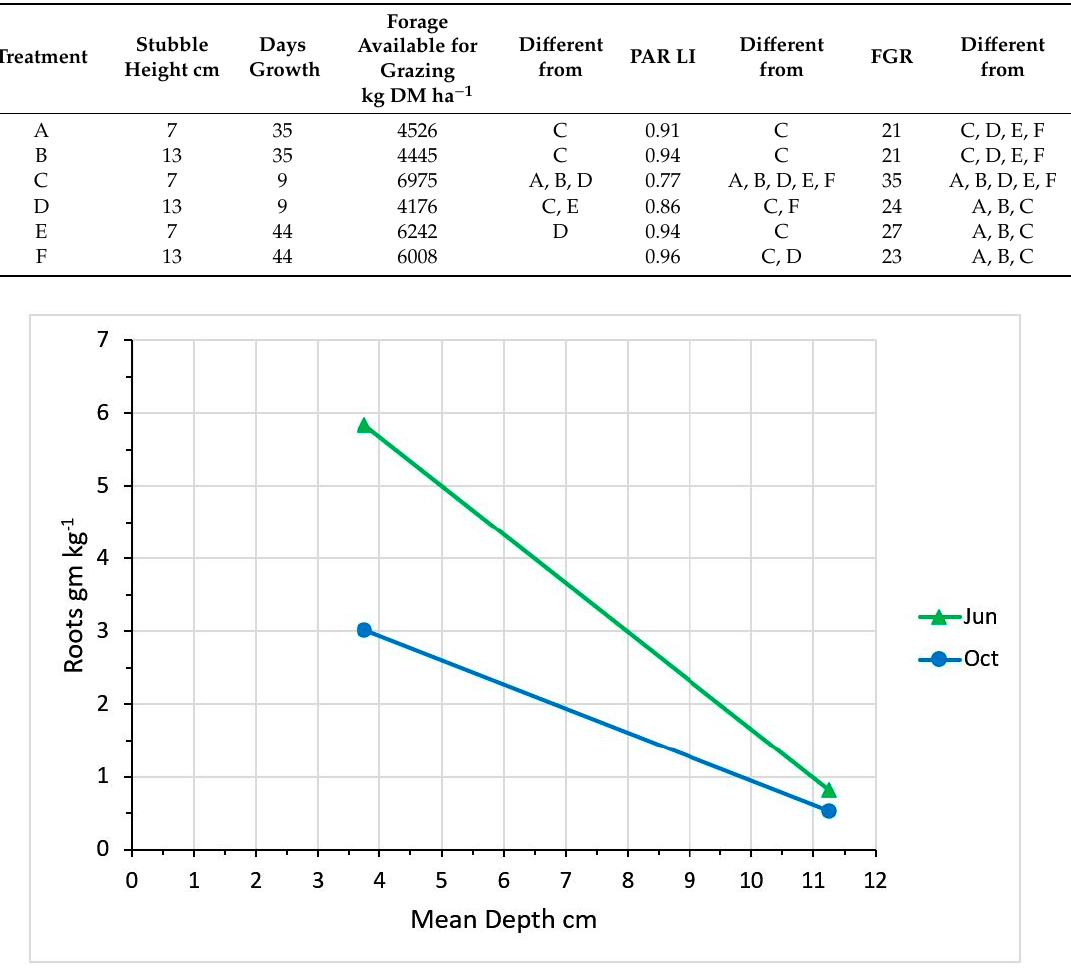
Figure 7. Root mass at mean soil depths for samples taken at 0 to 7.5 and 7.5 to 15 cm depths. Each data point represents the mean of 18 samples.